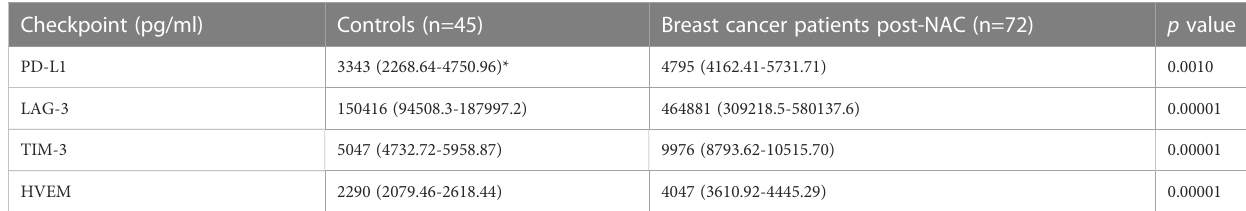
TABLE 4 Comparison of the plasma concentrations of the soluble co-inhibitory immune checkpoints, PD-L1, LAG-3 and TIM-3 and the soluble dual- activity checkpoint, HVEM, measured in the group of healthy control subjects and the cohort of early breast cancer patients post-neoadjuvant chemotherapy (NAC).